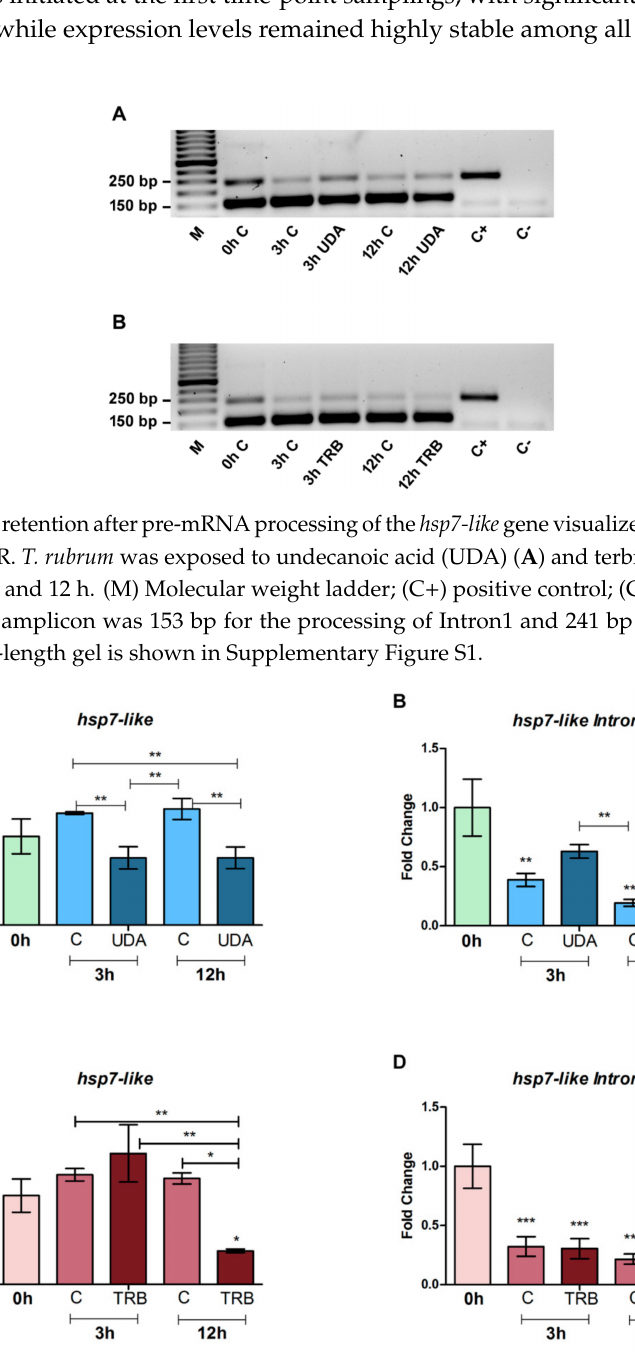
Figure 3. qPCR results for the hsp7-like gene after growth in the presence or absence of the antifungal drugs UDA and TRB for time points 0 h, 3 h, and 12 h. Expression levels are represented in comparison to the 0 h control. ( A ) Total expression, UDA exposure. ( B ) Intron-1 retention expression, UDA exposure. ( C ) Total expression, TRB exposure. ( D ) Intron-1 retention expression, TRB exposure. Data are means ± Standard deviation (SD). ( C ) Paired control. Significant statistical di ff erences are represented by asterisks (* p < 0.5, ** p < 0.01, *** p <